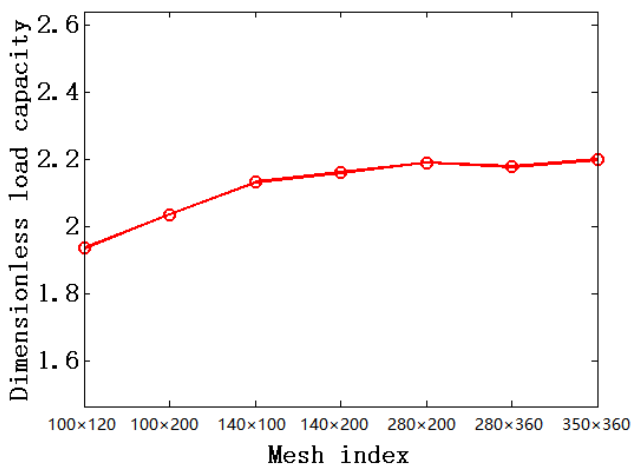
Figure 10. The influence of the mesh index on the calculation results.